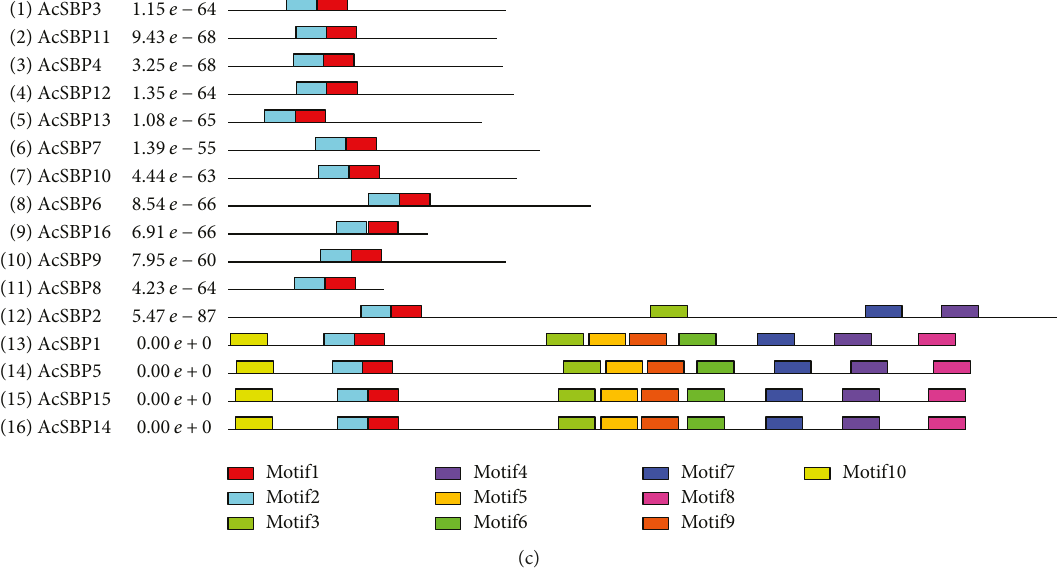
Figure 3: (a) Exon-intron structures of SBP genes in pineapple genome. All of the SBP genes were divided into four groups. Yellow color shows CDS (exon), blue color shows UTR (untranslated regions), and the normal line represents introns. (b) Sequence logo of SBP protein domains was obtained by MEME program. The overall height of each stack represents the degree of conservation at each position, while the height of letters within each stack indicates the relative frequency of amino acids. (c) Motif of SBP proteins in pineapple. MEME search tool was used to make motif